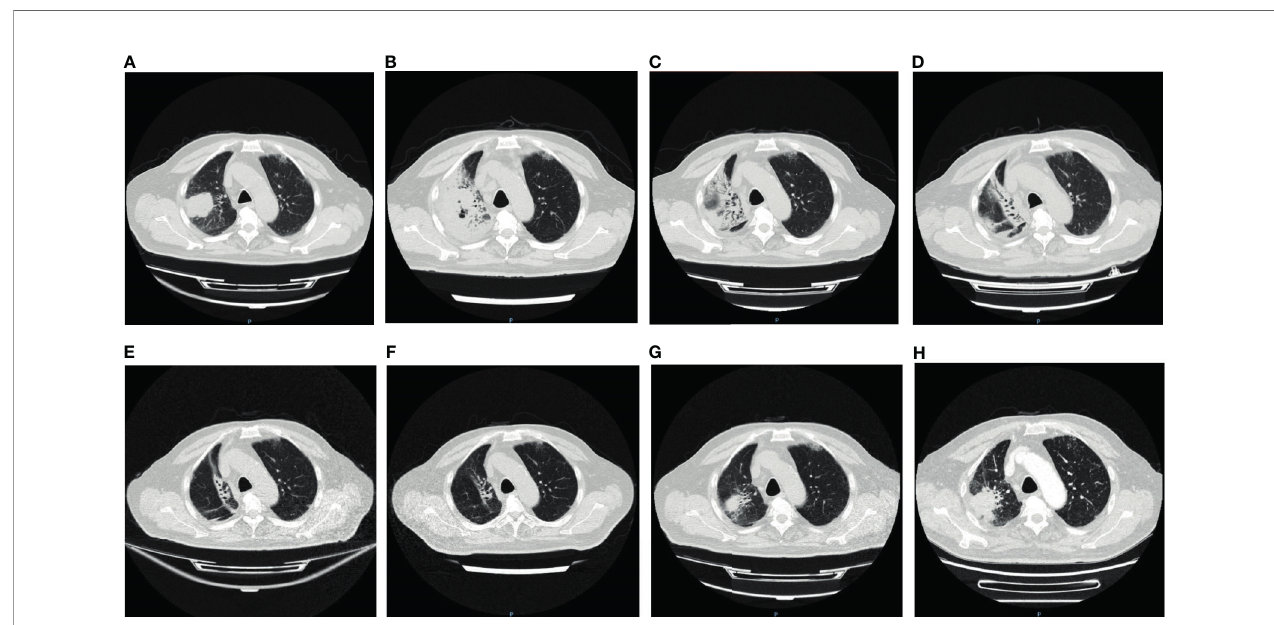
FIGURE 1 | The variation of the tumor and in fl ammation in Chest CT. (A) Pre-immunotherapy: the tumor was seen in the right lung; (B) 2 weeks after immunotherapy: patchy shadows appeared around the tumor and air holes occurred in the tumor; (C) 4 weeks after immunotherapy: more air holes developed in the tumor and patchy shadows; (D) 5 weeks after immunotherapy: the tumor and patchy shadows were dissipating; (E, F) 8/12 weeks after immunotherapy: the tumor disappeared, with several linear shadows leaving; (G) 16 weeks after immunotherapy: the tumor reappeared in original site; (H) 18 weeks after immunotherapy: the tumor